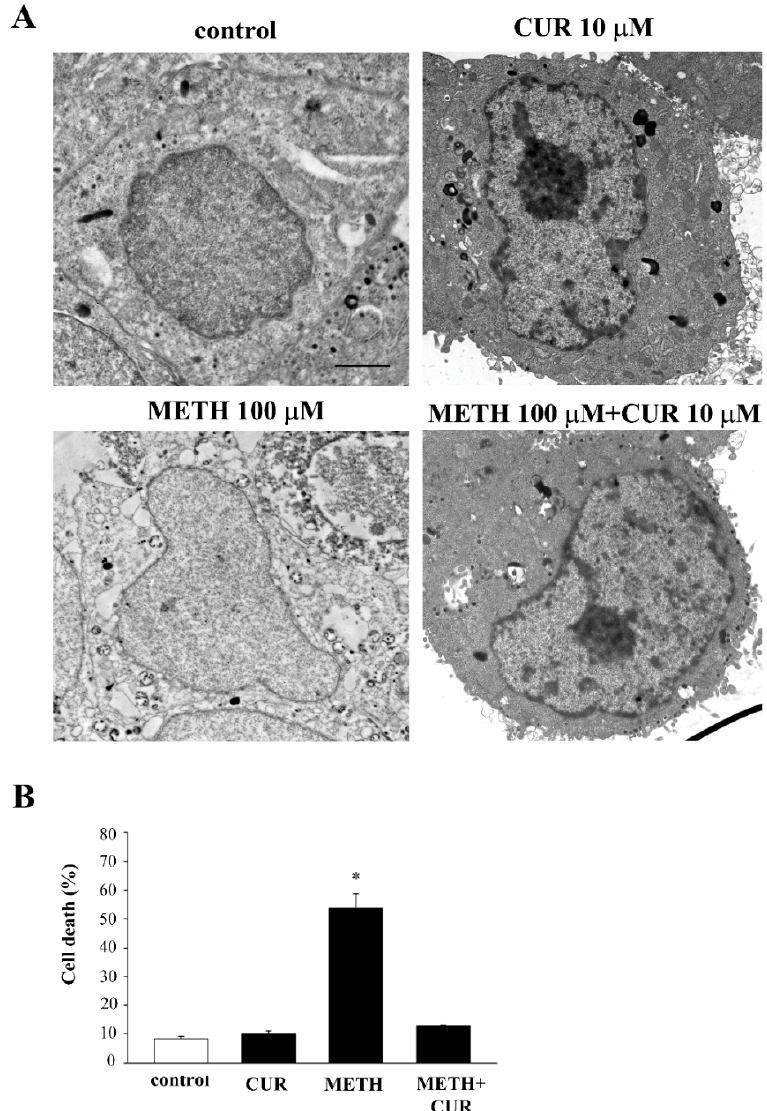
Figure 19. CUR prevents cell death. ( A ) Representative micrographs of PC12 cells showing a typical slow necrosis following METH administration. ( B ) The histogram reports the percentage of cell death (slow necrosis) counted at TEM. * p ≤ 0.05 compared with the other groups. Scale bar = 0.5 μ M.